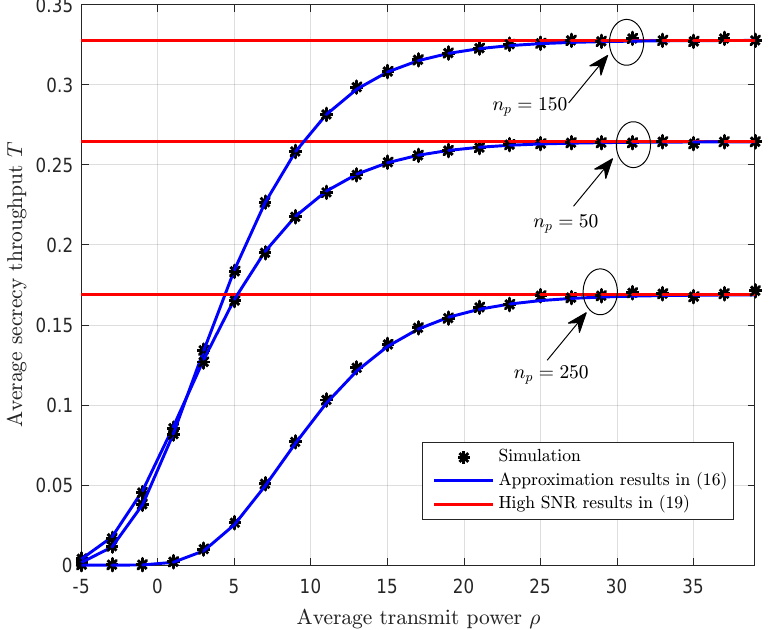
Figure 2. The average secrecy throughput T versus the average transmit power ρ with different channel training length n p , where α = 0.5, n = 300, ¯ γ sd = 0 dB, and ¯ γ se = 0